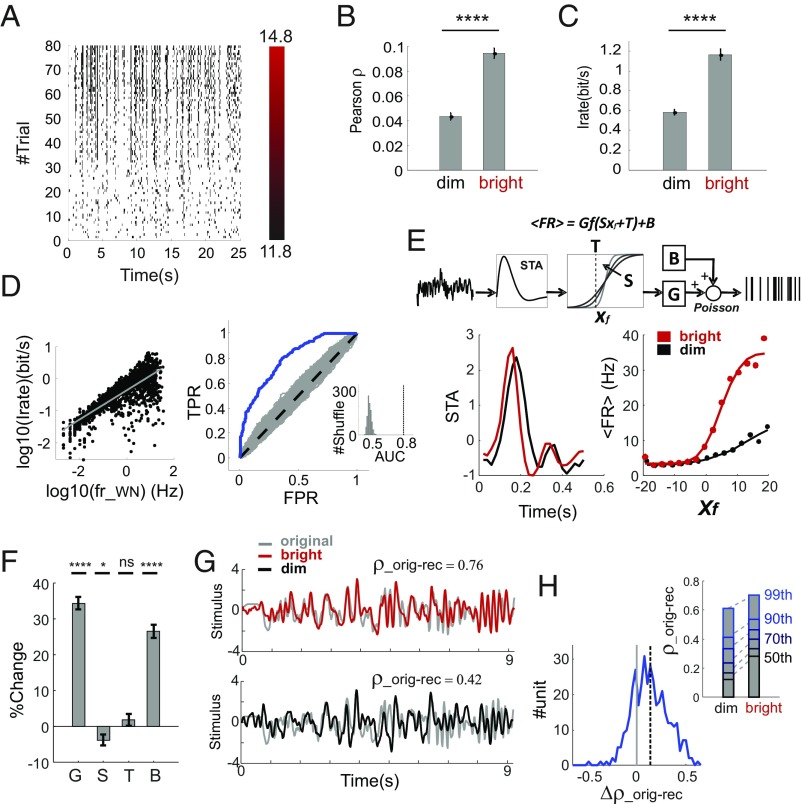
Impact of irradiance-driven increases in firing on neural coding. (A) Binarized trial bin counts for a representative unit from the RAMP+WN experiment to repeated presentations of the WN sequence. (B) Trial-to-trial reproducibility for units expressing increase in firing rates across the ramp were significantly higher in the last 40 trials (bright: 13.3–14.8 log10 photons⋅cm−2⋅s−1) compared with the initial 40 trials (dim: 11.8–13.3 log10 photons⋅cm−2⋅s−1). (C) As in B, but for information rate. (D) Firing and information rates are positively correlated (Left), and changes in firing rates across the ramp are predictive of changes in information rate (Right; Inset represents the shuffle test). (E) Schematic representation for the LNP model (Top) used to separately fit stimulus–response relations in dim- and bright-light conditions. STA (Bottom Left) and static nonlinearity (Bottom Right) in dim and bright conditions for a representative neuron. (F) Increases in response gain and baseline (G and B, respectively) were observed at high irradiance, while sensitivity and threshold (S and T, respectively) did not change (P ∼ 0 for G and B, P = 0.038 and 0.941 for S and T; n = 790; sign test). (G) Application of the model to reconstruct a stimulus based on firing patterns under bright (Top) and dim (Bottom) conditions, in the representative neuron [from E; colored and gray lines, reconstructed and original stimulus, respectively; correlation coefficients between reconstructed and original (ρorig-red) shown above]. (H) Histogram of differences in ρorig-red at high vs. low irradiance (Δρorig-red) in neurons showing increases in firing across the ramp, revealing a significant increase in ρorig-red at high irradiance (P ∼ 0; n = 385; sign test; dashed line shows mean). Inset shows quantiles for the distribution of ρorig-red for dim and bright condition. *P < 0.05, ****P < 0.0001.